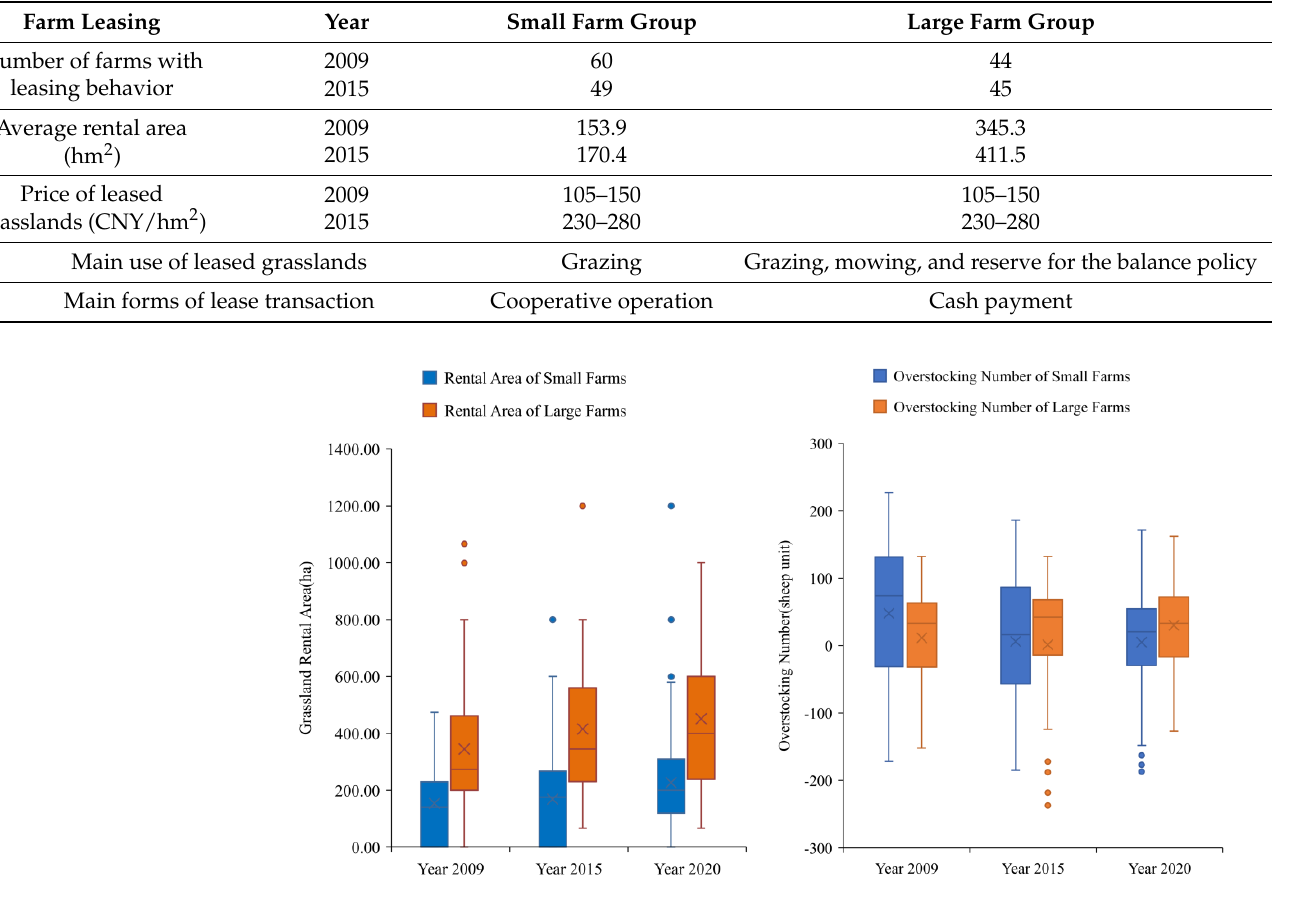
Table 2. Farm leasing for small and large farm groups.